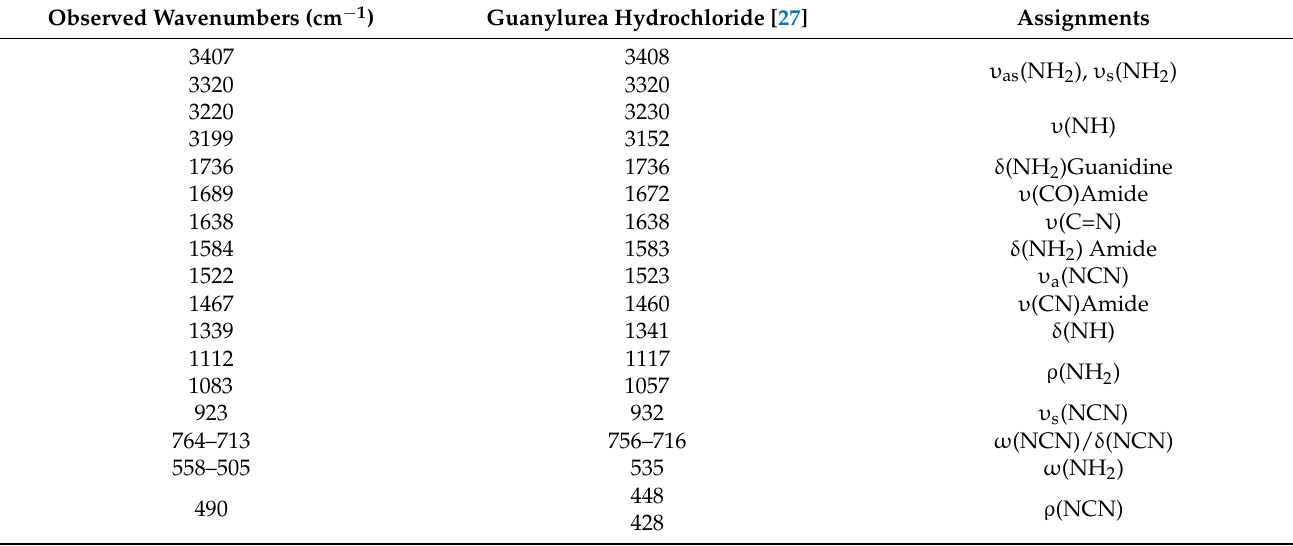
2 H 7 N 4 O) 2 BiCl 5 .